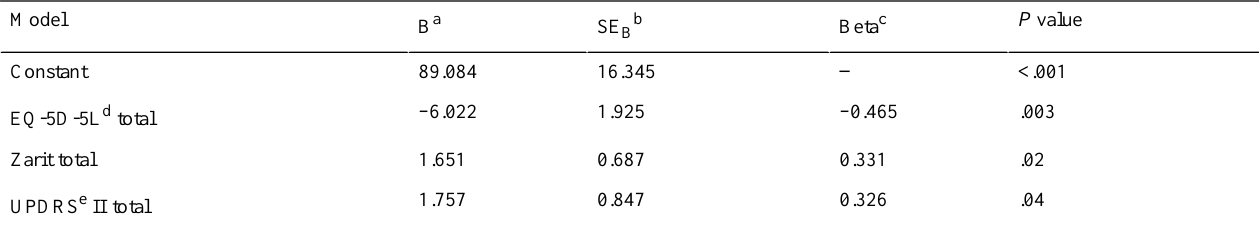
Table 4. Summary of multiple regression analysis.